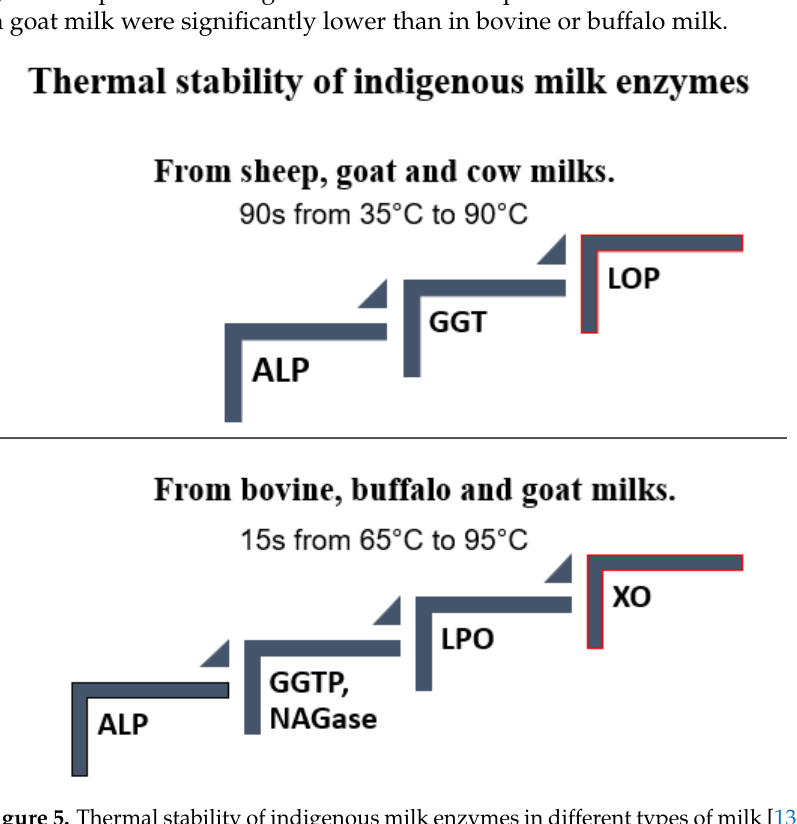
Figure 5. Thermal stability of indigenous milk enzymes in different types of milk [13,30]. ALP: alkaline phospahtase, GGT: γ -glutamyl transpeptidase, LPO: lactoperoxidase, NAGase: N-acetyl- β -glucosaminidase, XO: xanthine oxidase. ALP in non-cow-milk dairy products